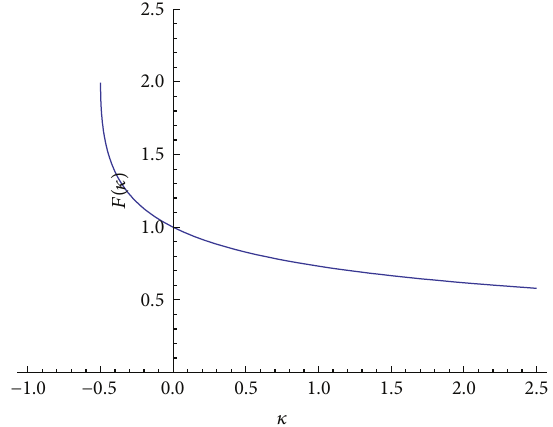
Figure 3: The curvature dependent speed function of the equivolu- metric evolution with the volumetric ratio 𝑆 0 = 1 is